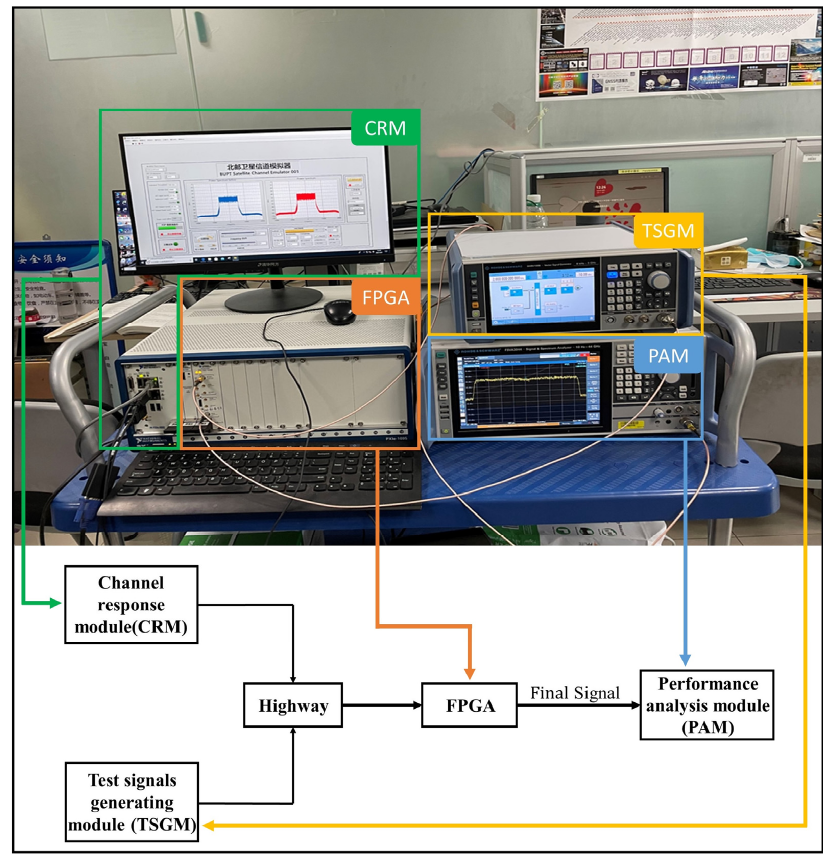
Figure 16. Test verification platform.